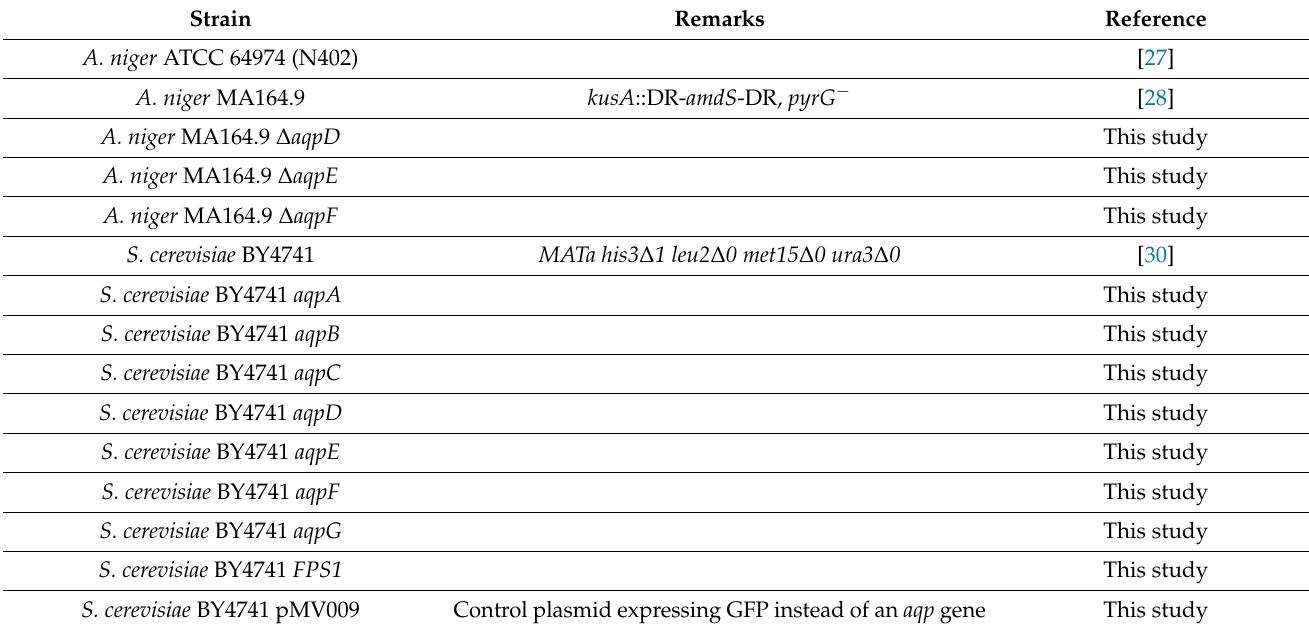
Table 1. Strains used in this